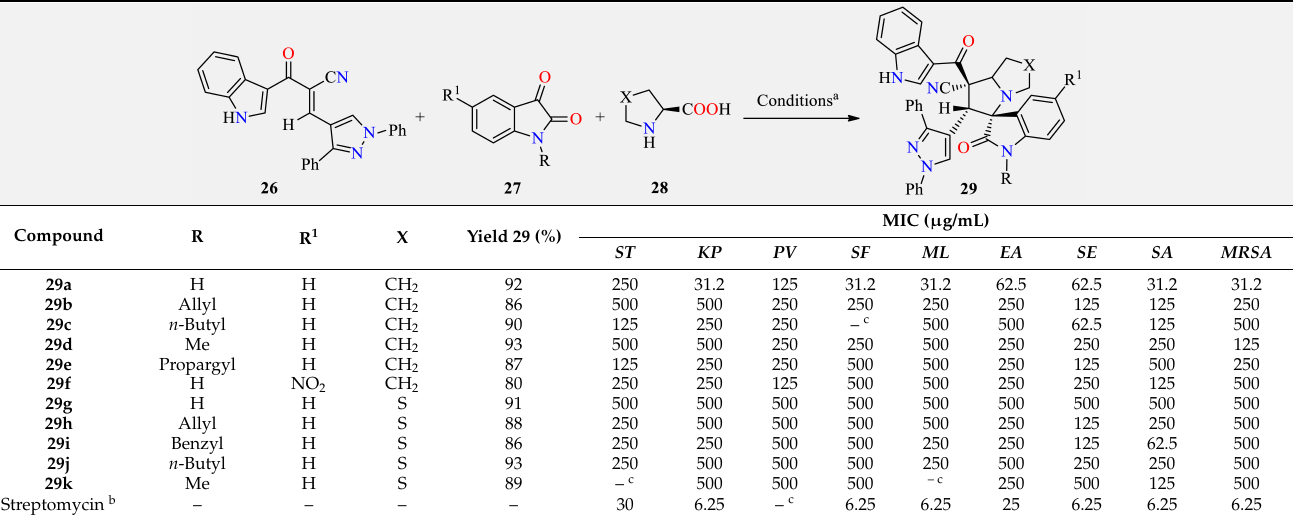
Table 6. Three-component synthesis and antibacterial activity of spiropyrrolidine-oxindoles 29 .